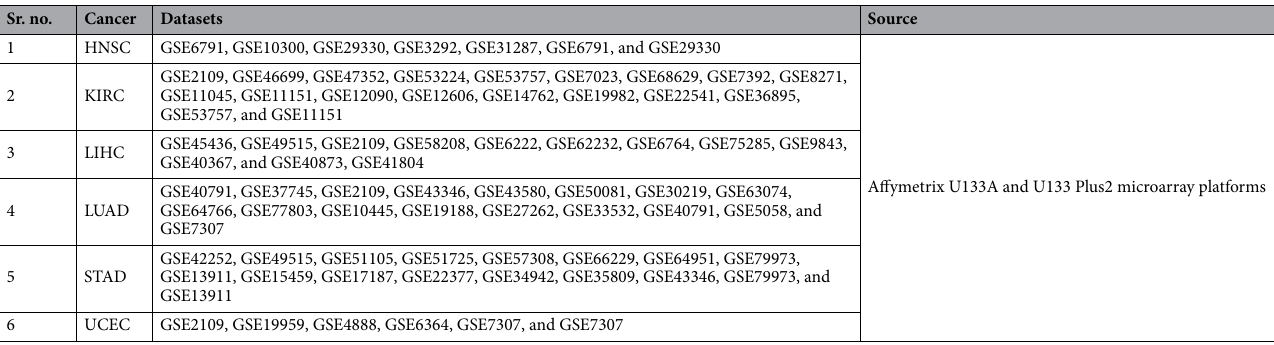
Table 2. Information of the HNSC, KIRC, LIHC, LUAD, STAD, and UCEC datasets used for the CTHRC1 expression validation via GENT2 webserver.